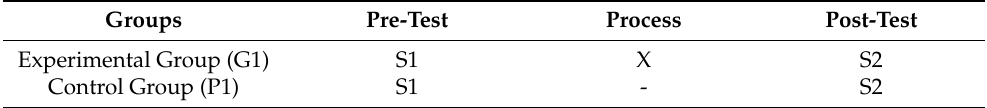
Table 1. Symbolic view of the research model.